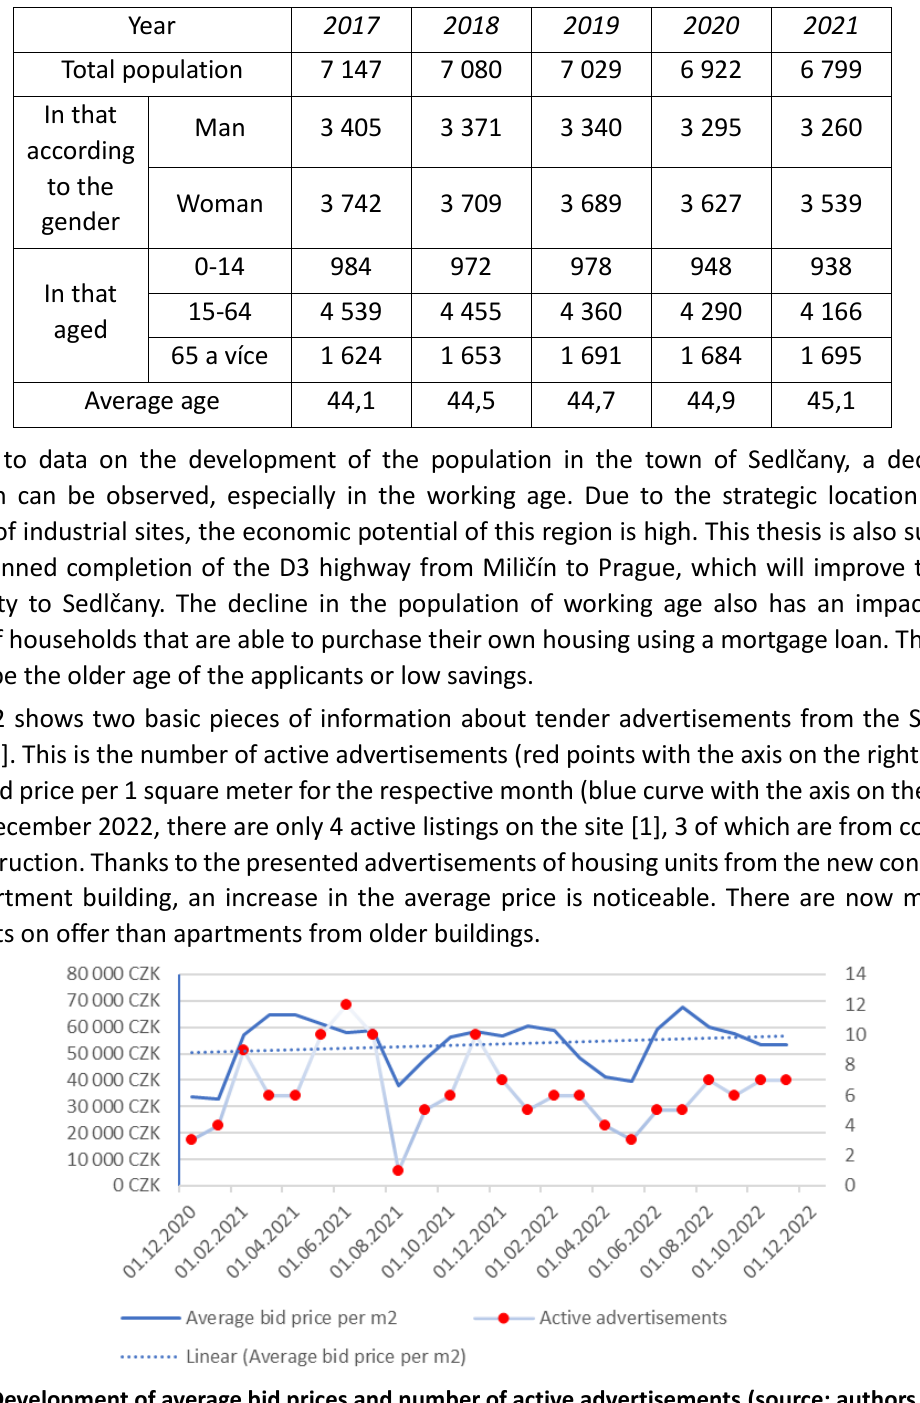
Figure 2: Development of average bid prices and number of active advertisements (source: authors with use of